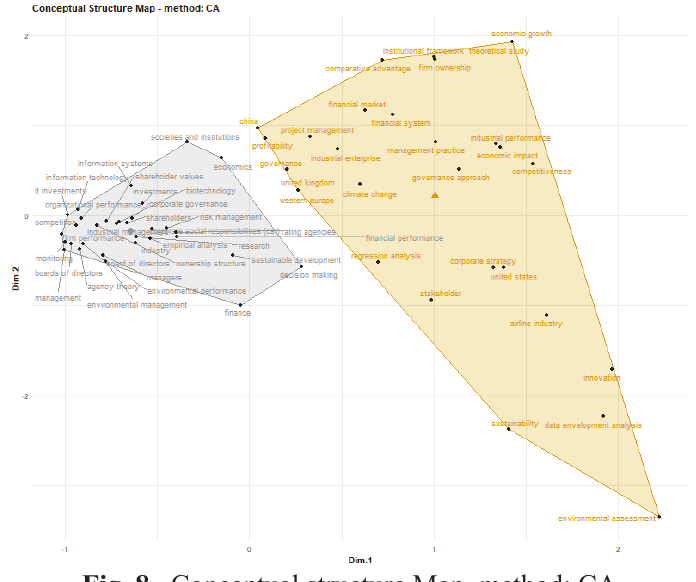
Fig. 8. Conceptual structure Map, method: